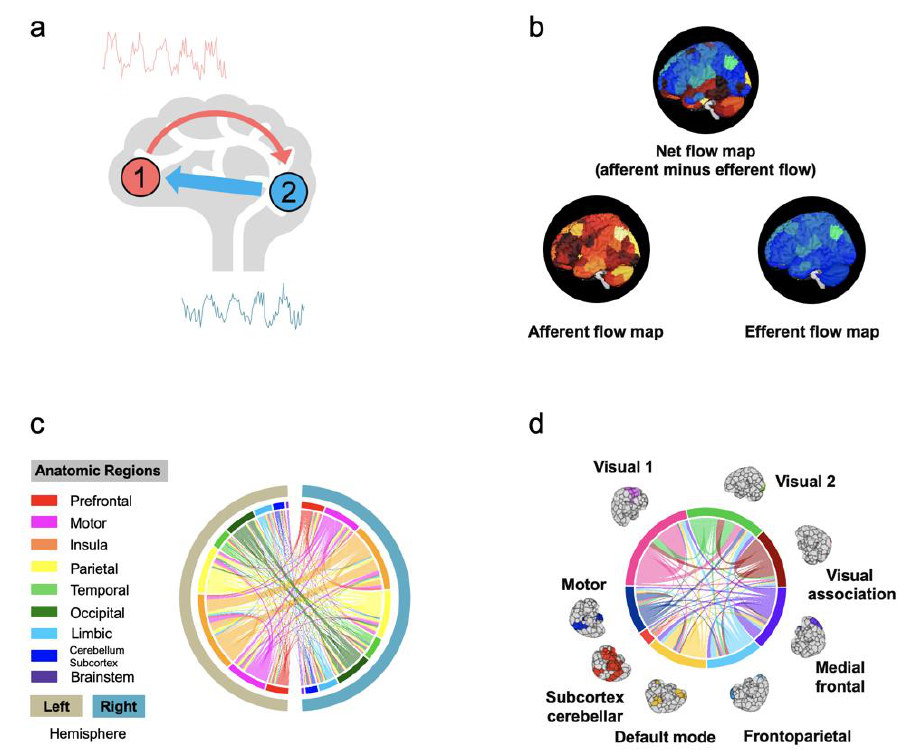
Figure 5. Information flows in the human brain. ( a ) Estimating information flows from a brain area 1 to another area 2—and from area 2 back to 1. This can be done using a statistical framework such as Granger causality analysis, dynamic causal modeling, and information theory (see Section 2.3). The direction and size of the arrows indicate the directed route and the amount of neural information traveling from one brain region to another. ( b ) A ff erent, e ff erent, and net information flow maps of the whole brain. The a ff erent flow measures the amount of information entering a particular brain area from other brain areas. The e ff erent flow measures the amount of information existing from a particular brain area to other brain areas. The net information flow quantifies the di ff erence between the two. ( c ) Average information flow between 18 anatomic regions. The 18 regions are organized based on a 268-node functional atlas. Average information flow is defined as the total amount of information flow from each anatomic region divided by the number of nodes in the region. The colour of the edge indicates the origin of the flow. For example, the pink curved line crossing the circle starting from the lower left (pink bar) to the top right (light orange bar) indicates information flow from left motor region to right insula region. ( d ) Average information flow between eight functional networks. The edges are now visualized on eight functional brain networks. The images are adapted and modified, under the terms of the Creative Commons CC BY license, from Scientific Reports “Resting-state brain information flow predicts cognitive flexibility in humans” by Ch é n et al. Copyright 2019